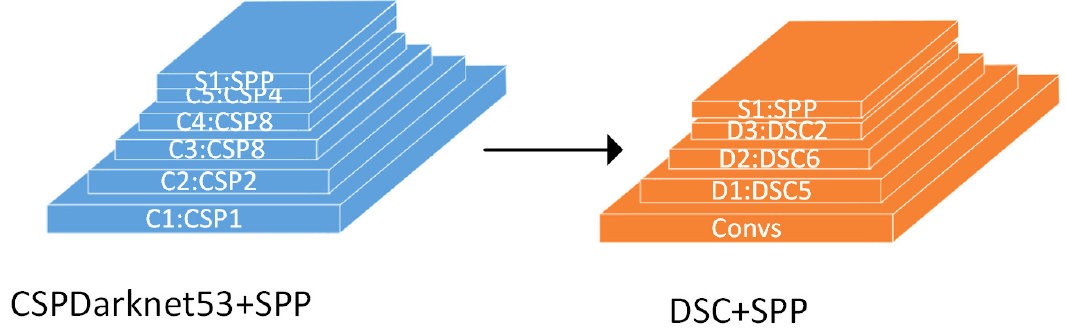
Figure 11. Improved backbone feature extraction